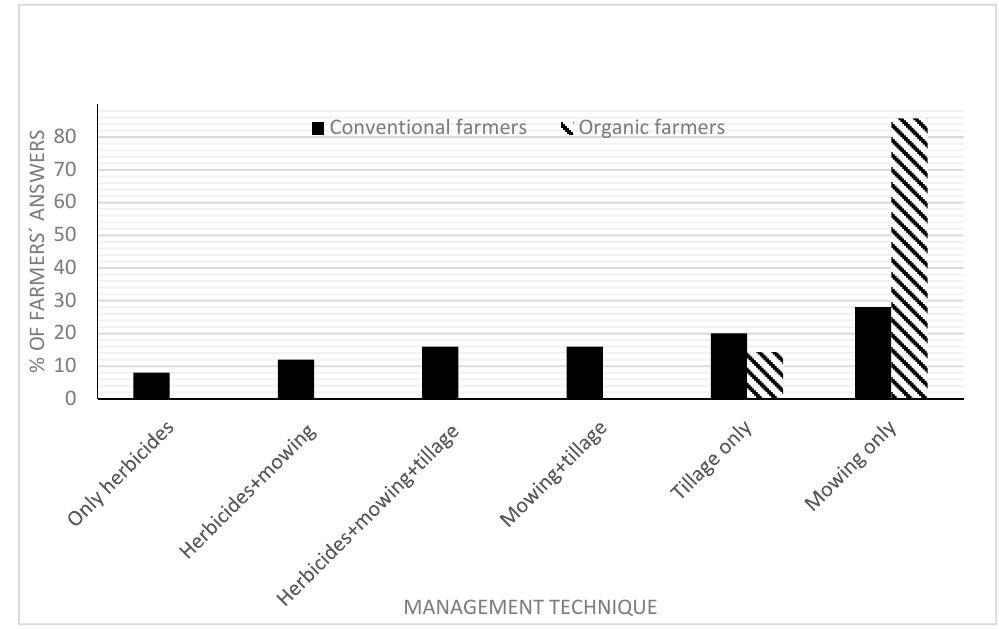
Figure 6. Ground vegetation management techniques among organic ( n = 16) and conventional ( n = 23) olive farmers in Messenia, Greece.